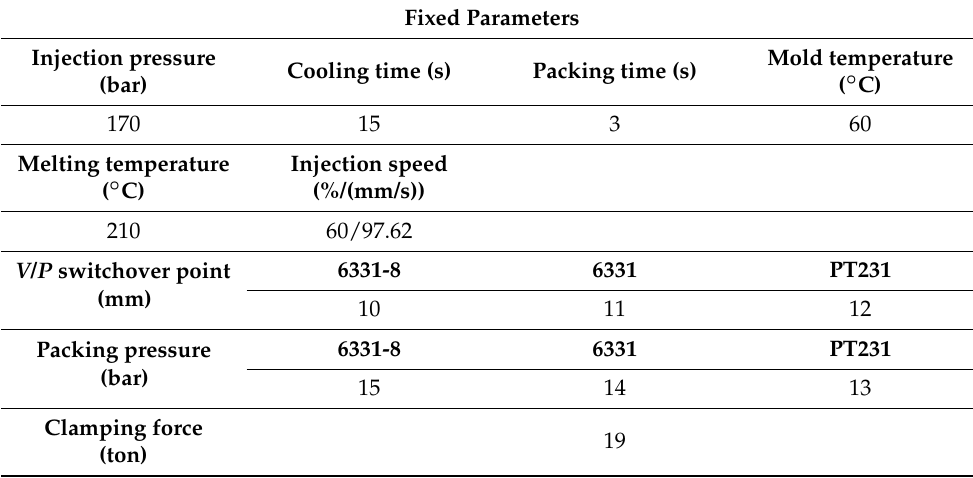
Table 6. Adaptive process control system’s experiment parameters.